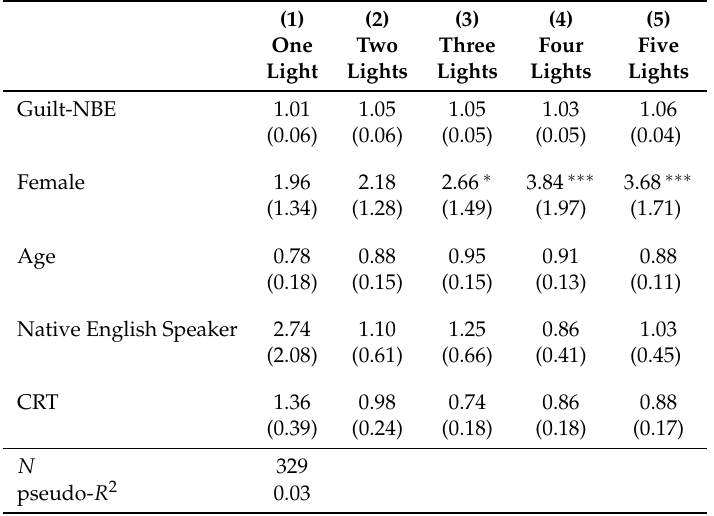
Table A5. Predicting Number of Lights by ToM: Multinomial Logit Regression.